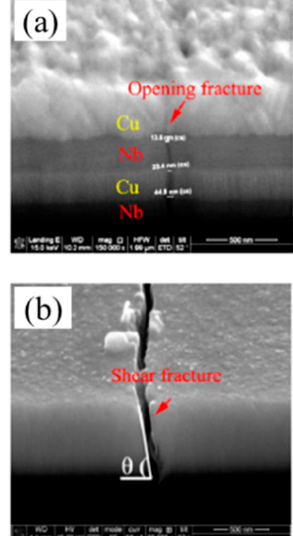
Figure 15. FIB cross-sectional images of microcracks of Cu/Nb NMMFs with ( a ) h Cu = 125 nm and ( b ) h Cu = 5 nm [8].